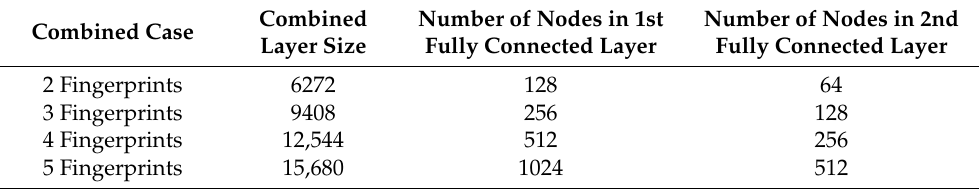
Table 9. Details of the first and second fully connected layers for every